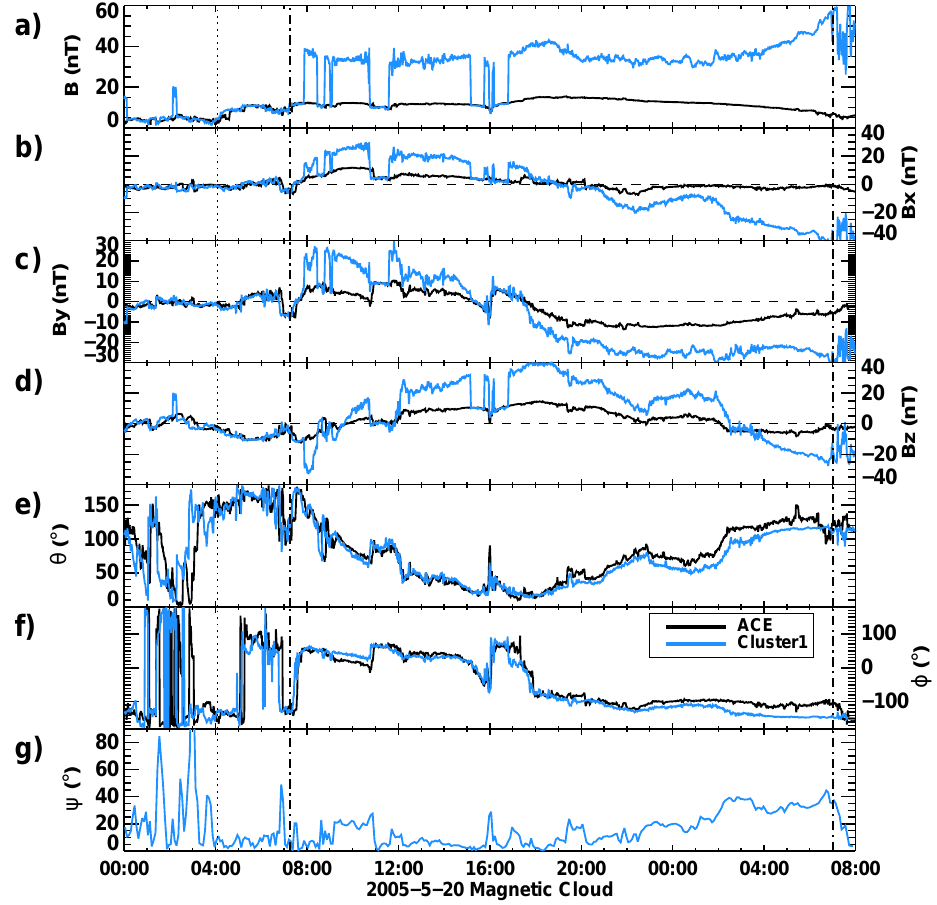
Figure 2. 20 May 2005 MC: observations from ACE (black) and Cluster (blue), in GSE coordinates. Vertical dotted line: beginning of the sheath of the MC. Vertical dotted–dashed lines: beginning and end of the MC. From top to bottom: magnetic field strength; B x ; B y ; B z ; θ ; ϕ (see text for definition of θ and ϕ ); and ψ , the angle between the magnetic field observed by Cluster and by